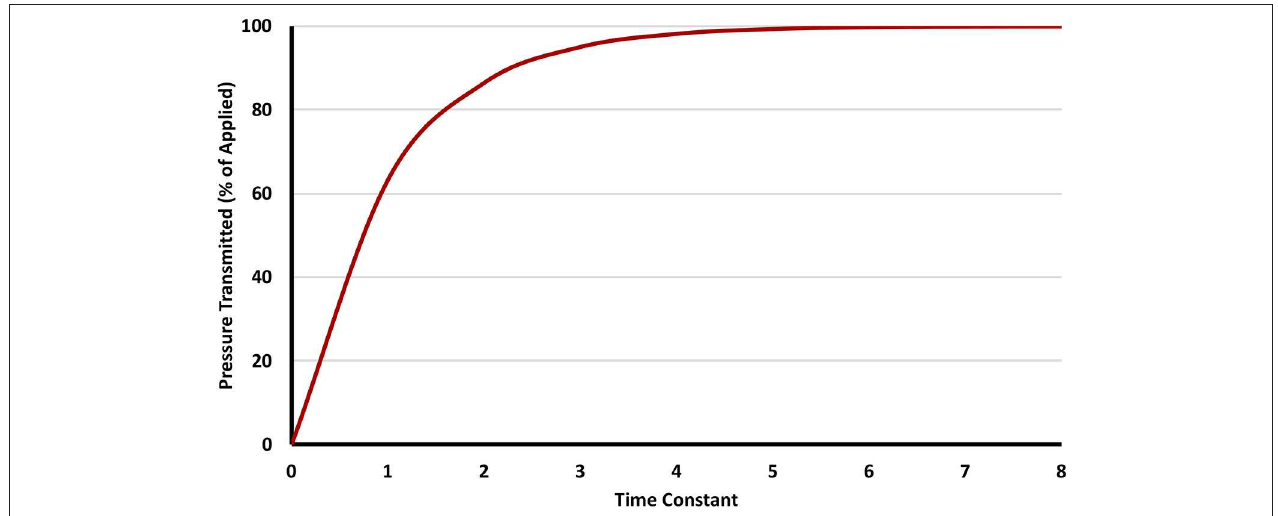
FIGURE 1 | The relationship between time constant and delivered pressure. Three to five time constants are needed to transmit > 95% of the pressure applied.